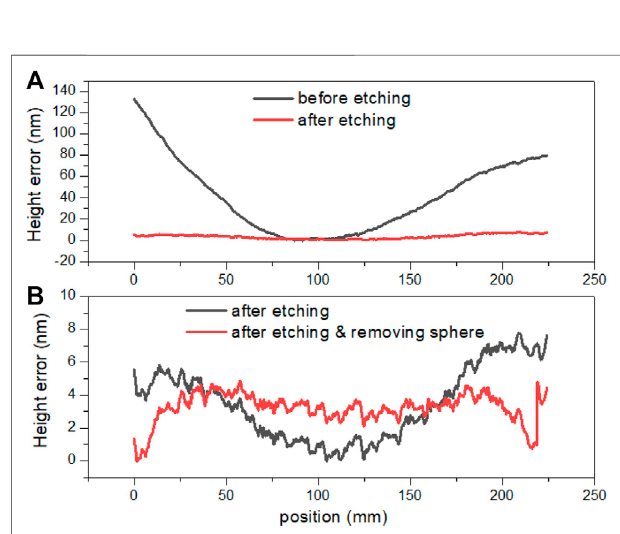
FIGURE3|(A) One-dimensionalheightpro fi lealongthelengthdirection of VFM before and after IBF. (B) Height error after IBF without and with the best- fi t sphere was